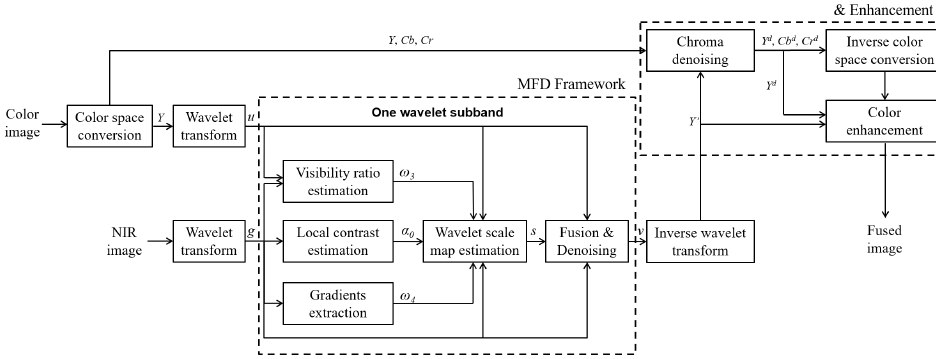
Figure 1. The entire framework of the proposed method (MFD: Multi-spectral fusion and